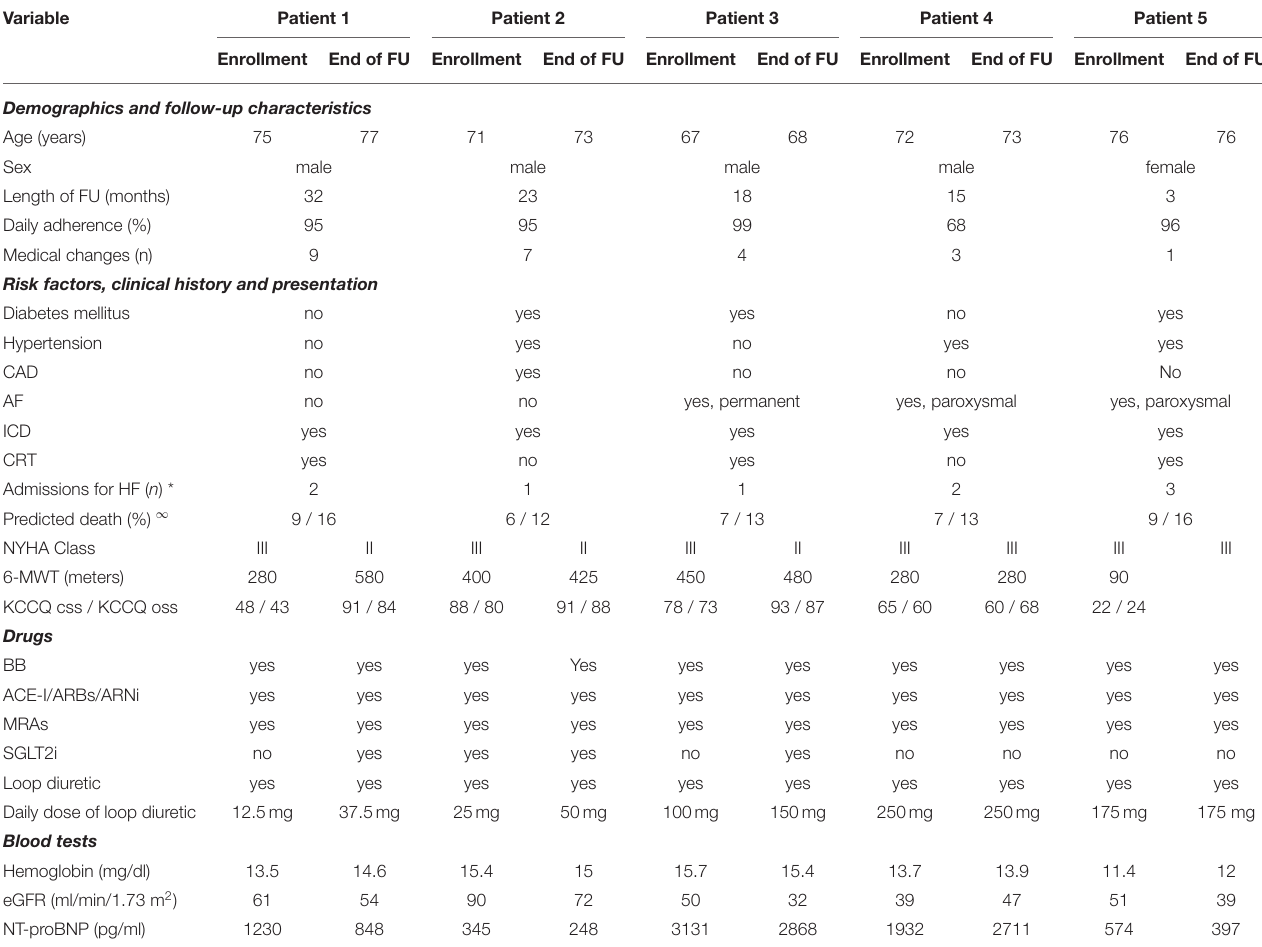
TABLE 1 | Clinical characteristics of the patients included.